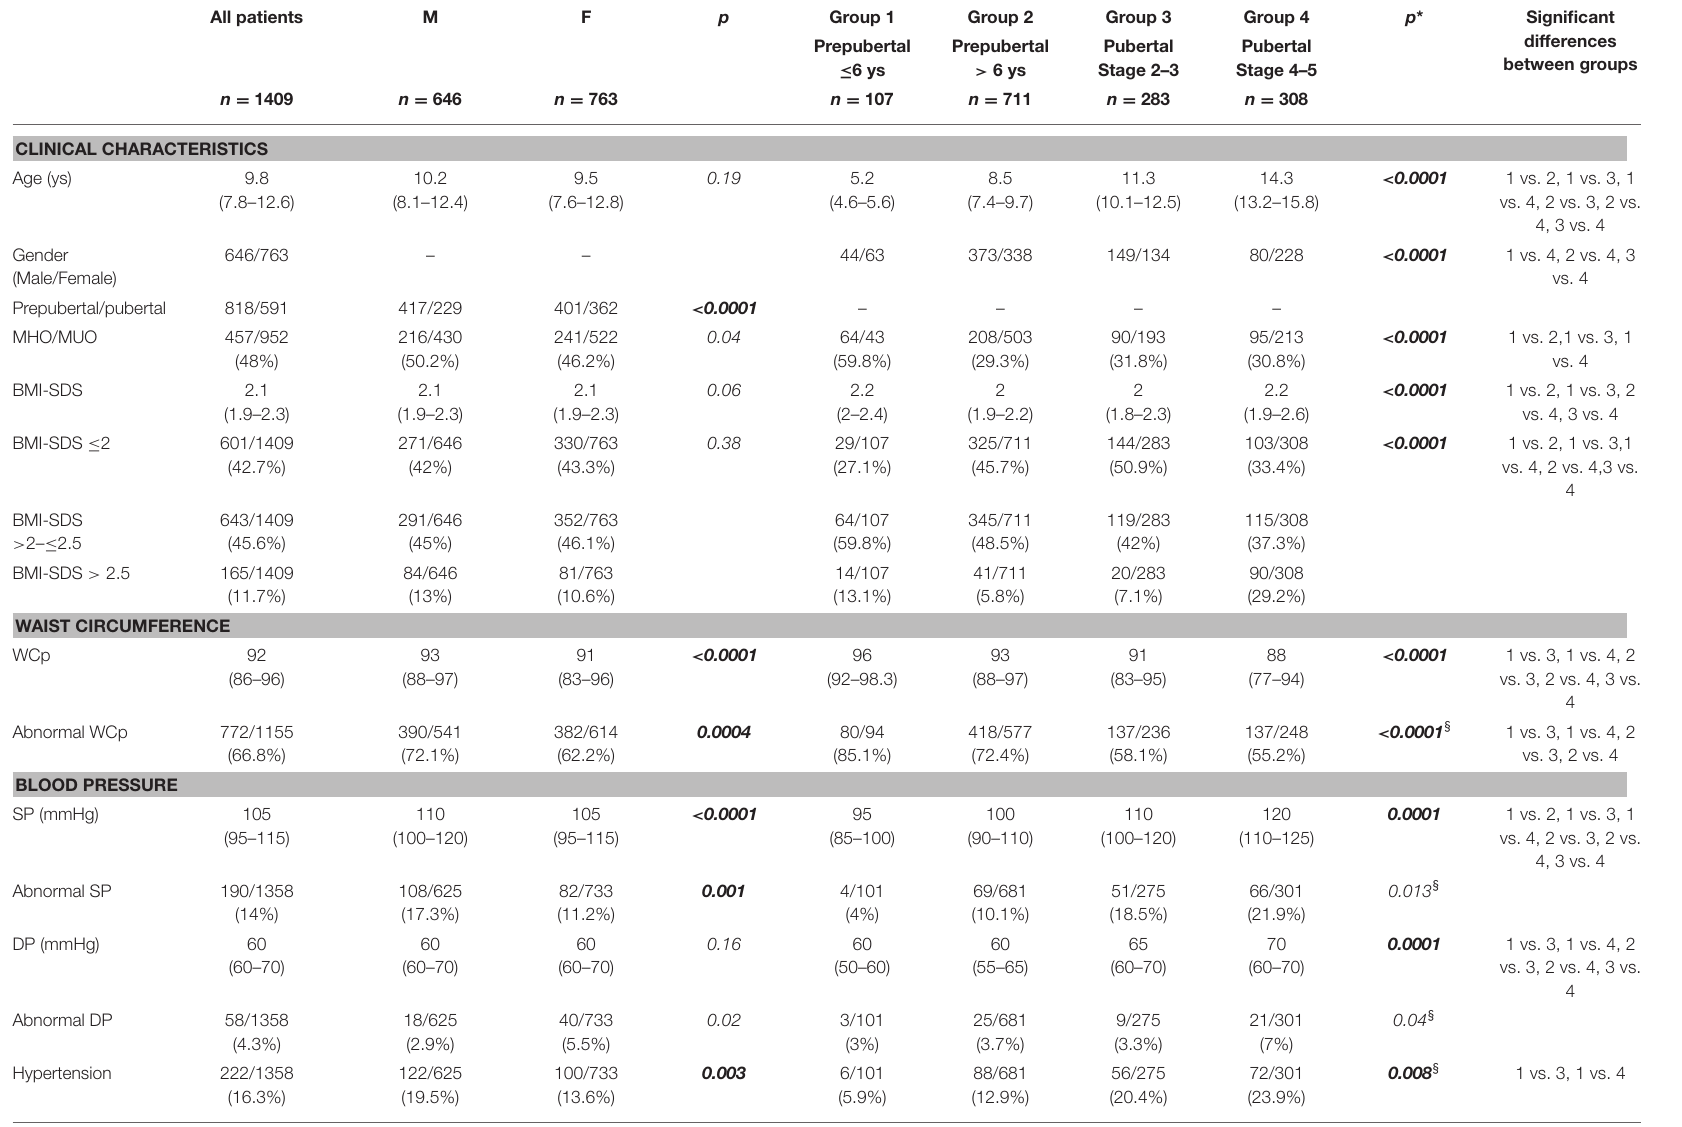
TABLE 1 | Clinical and biochemical characteristics of the patients. All